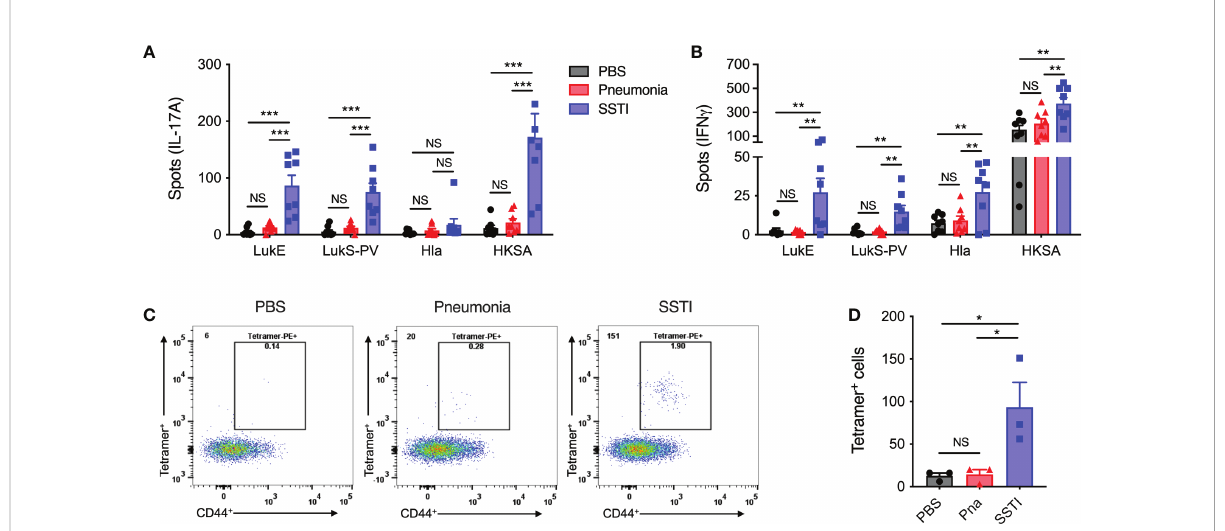
FIGURE 2 SSTI, but not pneumonia, elicits antigen-speci fi c memory T cells. 4 weeks following primary SSTI or pneumonia, S. aureus -speci fi c T cell responses were quanti fi ed by ELISpot or pMHC tetramers speci fi c for a common LukE/LukS-PV-speci fi c epitope (LkT/C:I-E d ). (A, B) Incubation of splenocytes with heat-killed S. aureus (HKSA) resulted in more IL-17A- and IFN g -secreting T cells following SSTI, compared with pneumonia. There were also more cytokine-secreting T cells following incubation with LukE (IL-17A, IFN g ), LukS-PV (IL-17A, IFN g ), and Hla (IFN g ) in mice that received SSTI, compared with mice that received pneumonia. (C, D) There were increased numbers of pMHC (LkT/C:I-E d ) staining CD4 + CD44 + T cells following SSTI, but not pneumonia. N=8 mice/group pooled from 2 independent experiments (A, B) or 3 mice/group from